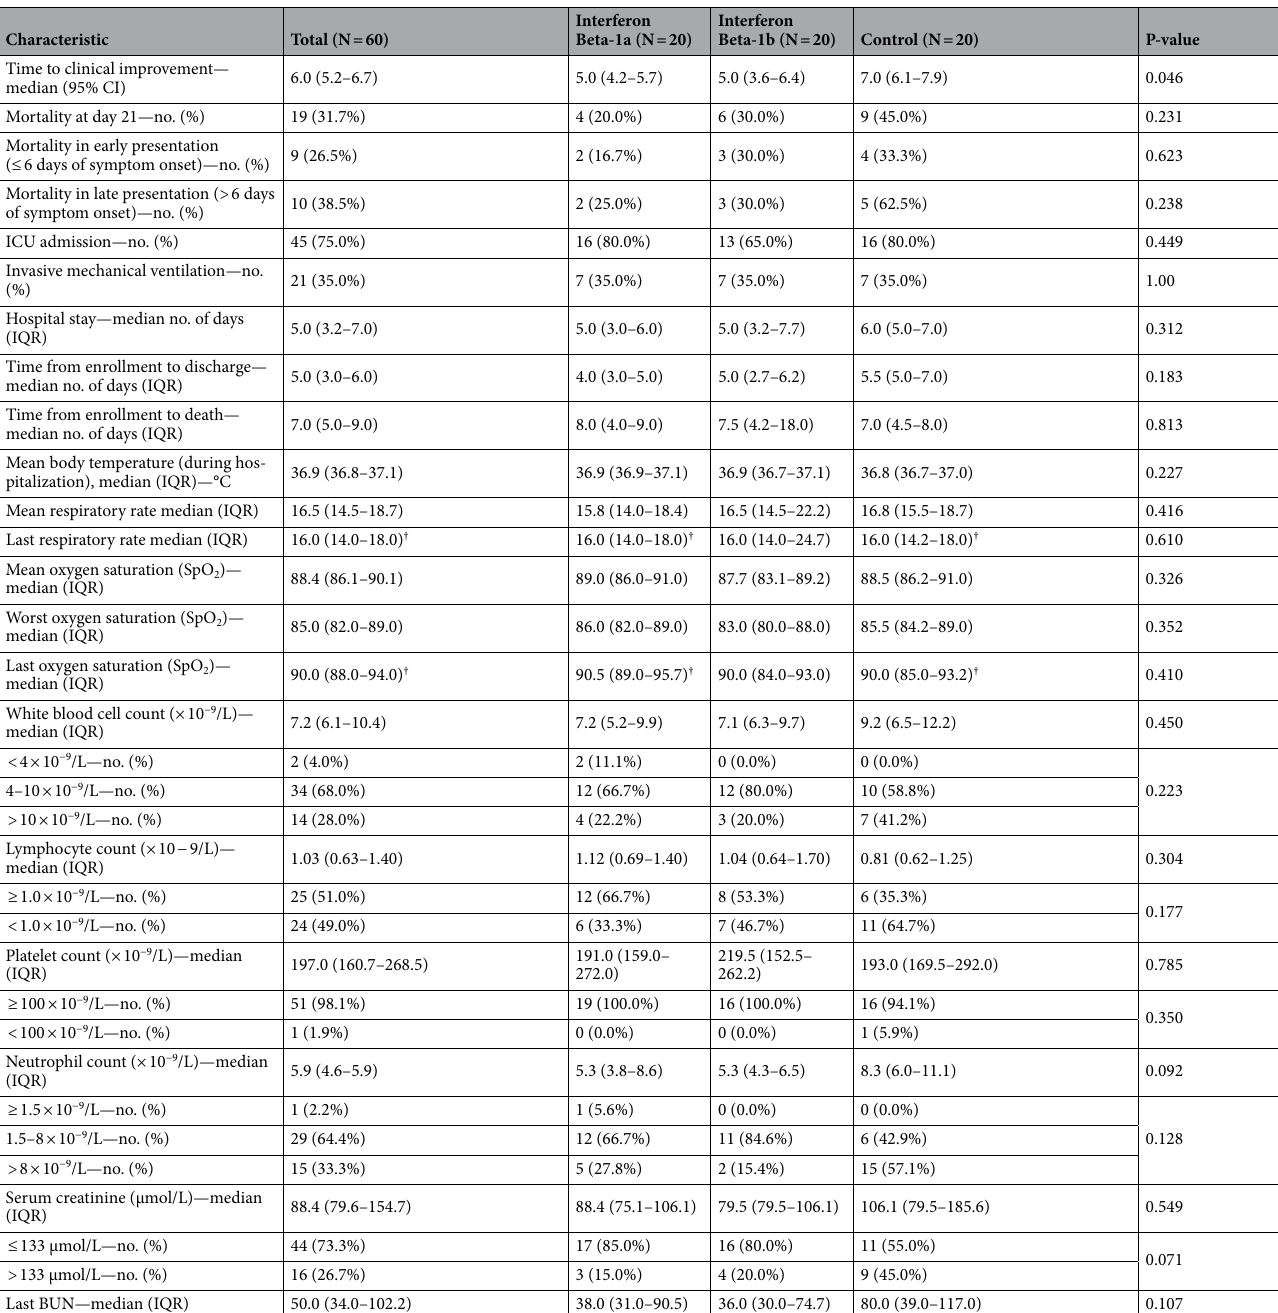
Table 2. Outcomes in the intention-to-treat population. The values are based on analysis of available data. Laboratory values for White Blood Cell count and Lymphocyte count were available for 18 patients in Interferon Beta-1a, 15 patients in the Interferon Beta-1b, and 17 patients in the control group. Values for Platelet count were available for 19 patients in Interferon Beta-1a, 16 patients in the Interferon Beta-1b, and 17 patients in the control group. Values for Neutrophil count were available for 13 patients in Interferon Beta-1a, 11 patients in the Interferon Beta-1b, and 6 patients in the control group. IQR denotes the interquartile range. Quantitative measures were compared using the Kruskal–Wallis test. Categorical variables were compared using the Chi-Square test. Comparisons before and after intervention have been made using The Wilcoxon signed-rank test. † Statistically significant in comparison to the